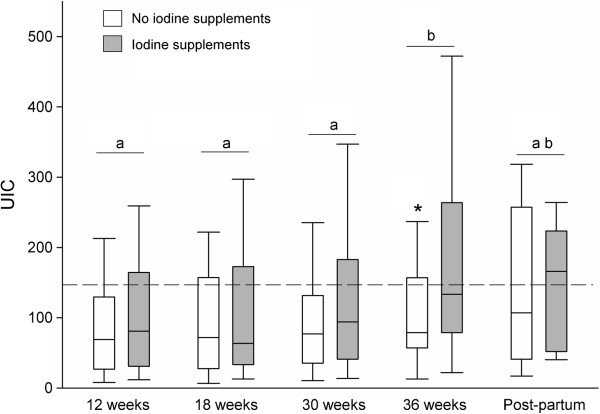
Urinary iodine concentrations during pregnancy and 6 months postpartum according to the use of iodine-containing multivitamins, measured at 12 weeks (no iodine-containing multivitamins n = 89, iodine-containing multivitamins n = 76), 18 weeks (no iodine-containing multivitamins n = 81, iodine-containing multivitamins n = 79), 30 weeks (no iodine-containing multivitamins n = 58, iodine-containing multivitamins n = 62) 36 weeks (no iodine-containing multivitamins n = 51, iodine-containing multivitamins n = 60) and at 6 months post-partum (no iodine-containing multivitamins n = 21, iodine-containing multivitamins n = 17). Line and boxes represent the median and the inter-quartile range and whiskers represent the 95% confidence interval. *p < 0.05 between iodine supplement and no supplement group at 36 weeks (Mann Whitney U test); significant differences across gestation are represented by different alpha symbols (p < 0.01).